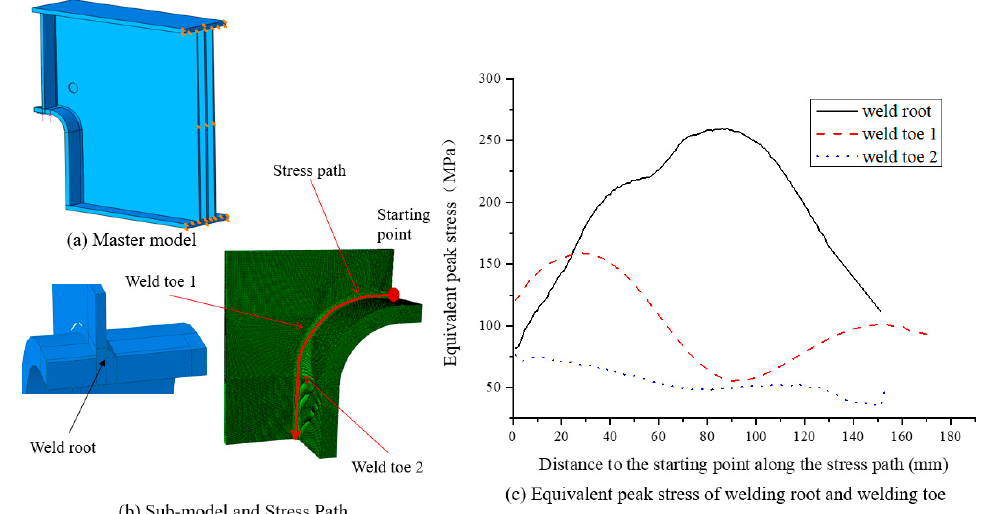
Figure 15. Peak stress analysis model and results for the variable-section supports with R-plates and three-web plates.